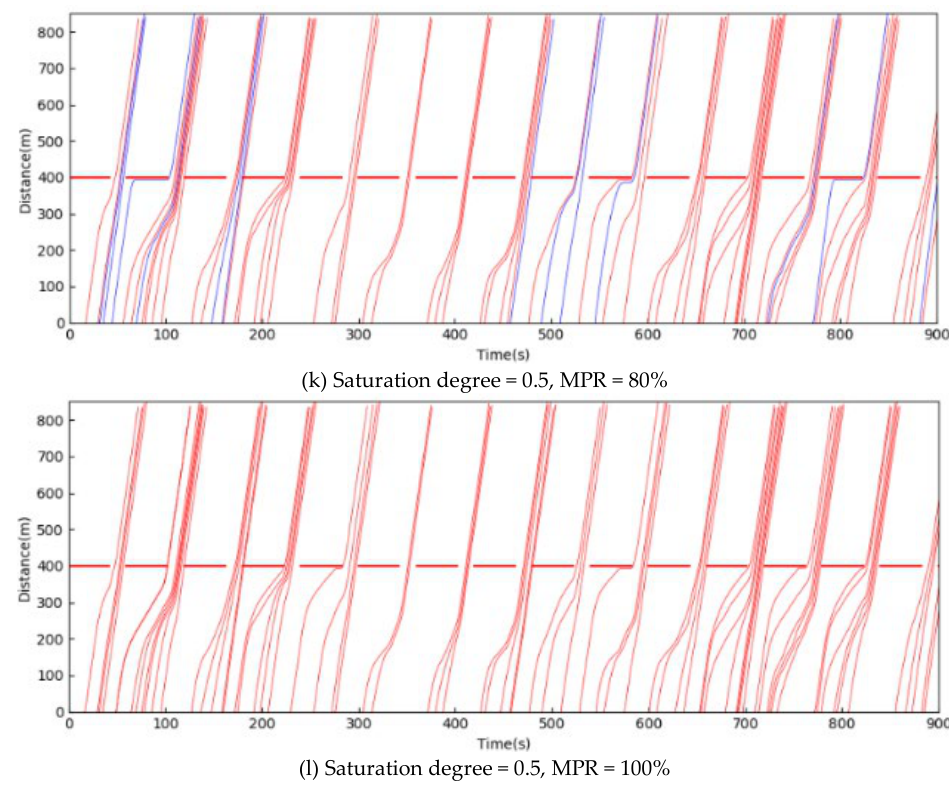
Figure 10. Spatial–temporal trajectories for different MPRs under saturation degrees of 0.2 and 0.5.